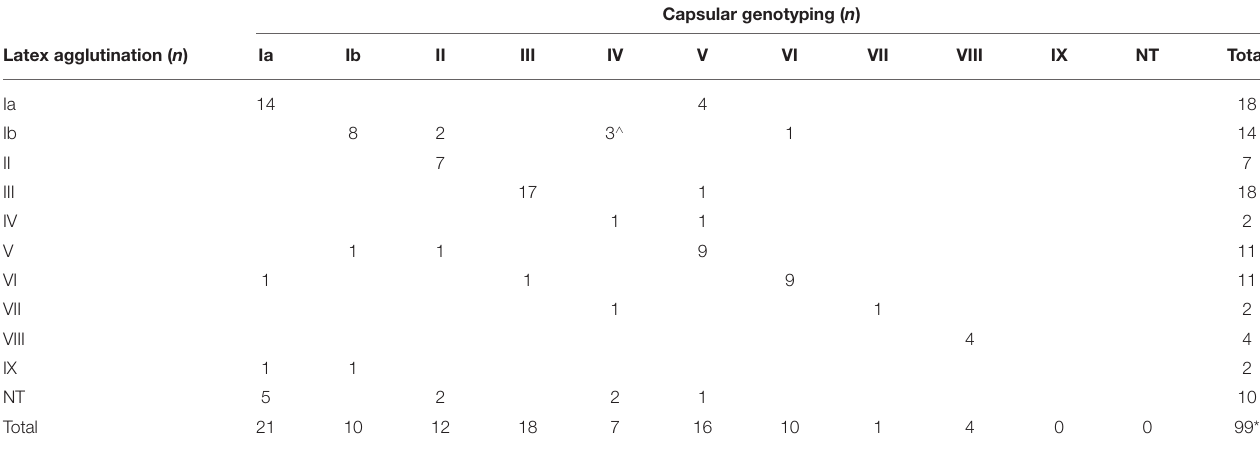
TABLE 5 | Comparison of capsular genotypes of sequenced study isolates ( n = 100) compared to capsular serotype obtained by latex agglutination.